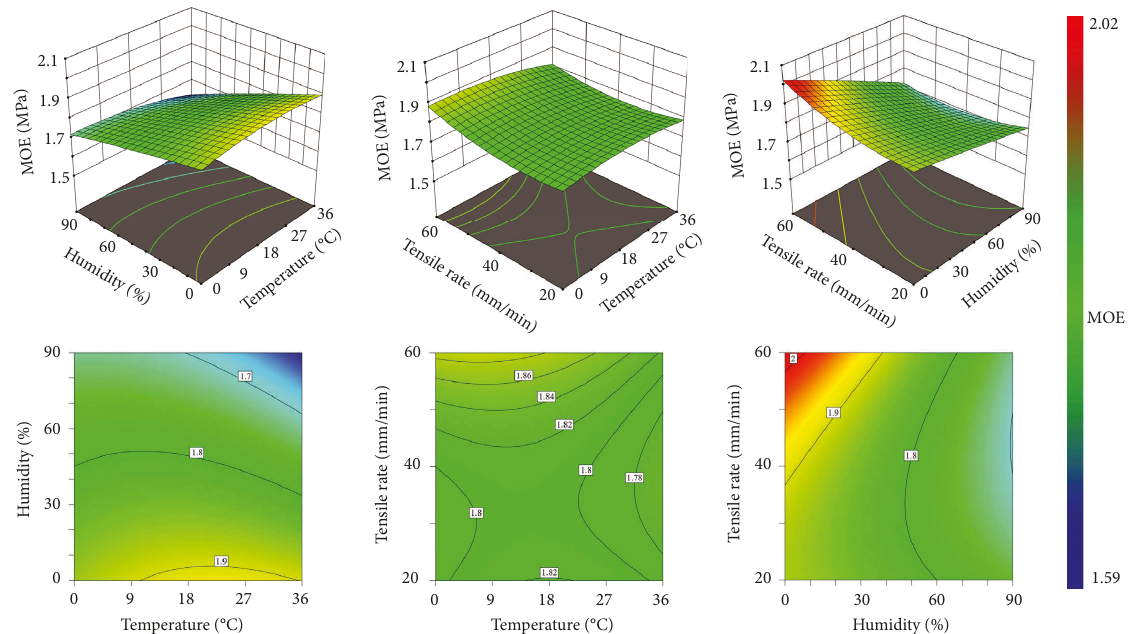
Figure 4: 3D surface profile displaying the effect of processing parameters on MOE: (a) temperature and humidity; (b) temperature and stretching rate; (c) humidity and stretching